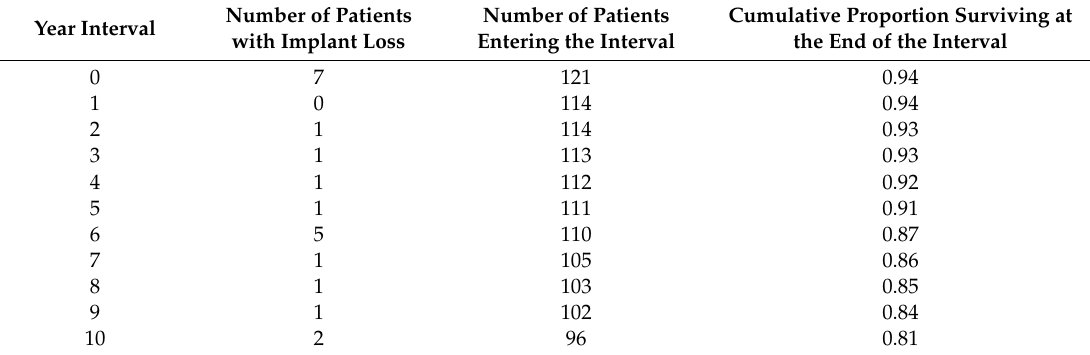
Table 2. Life table showing an overview of failures and the overall cumulative survival rate on the patient level.